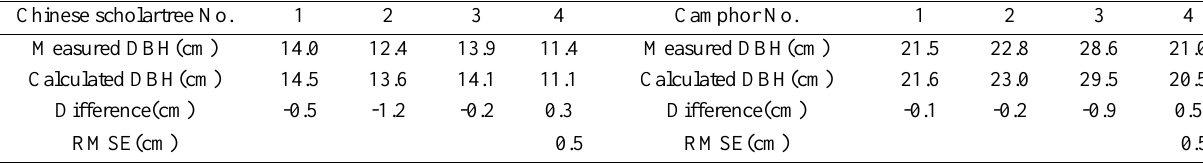
Table 3. DBH calculation results